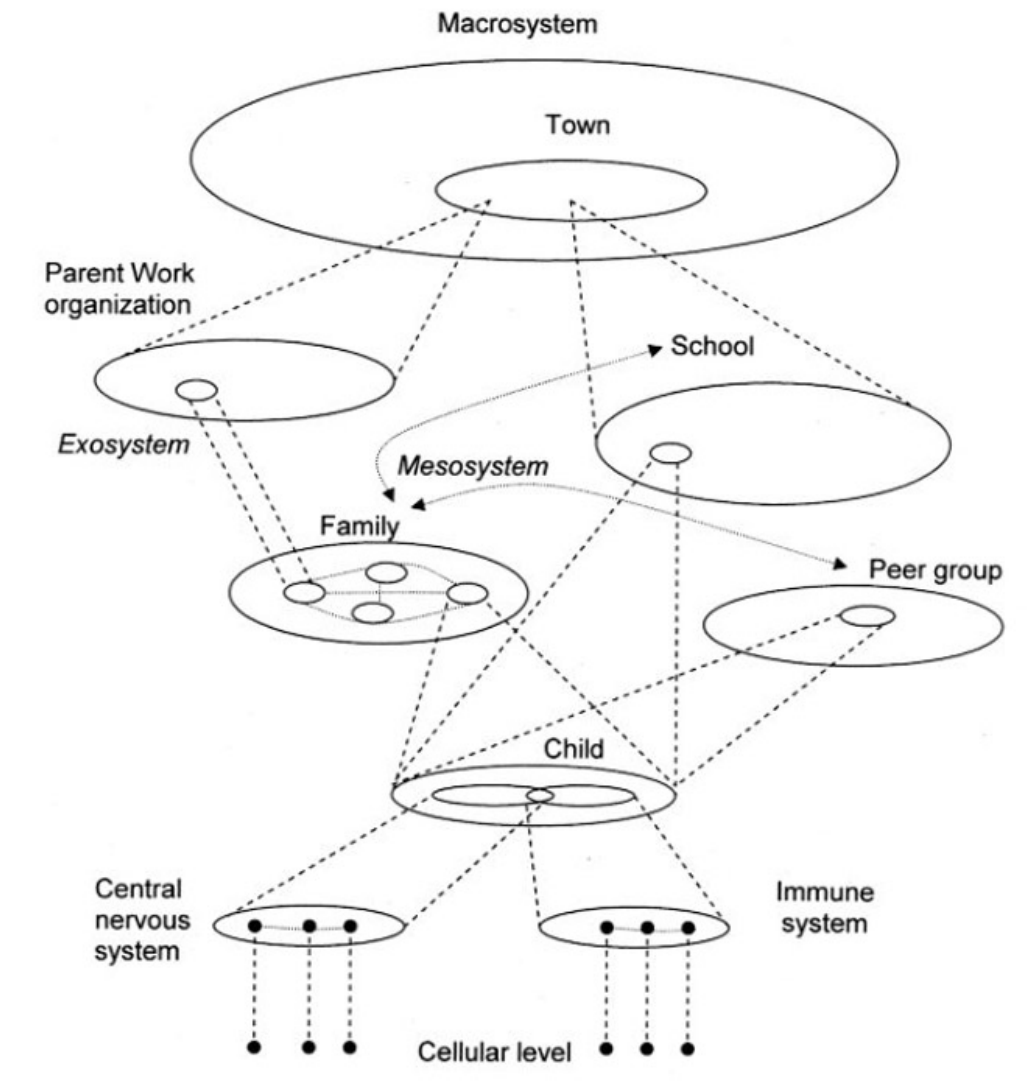
Fig. 2 . Multiple-level embedded systems that interact to influence a child’s life illustrating Bronfenbrenner’s (1979, 1986) concepts. The child as a living system is shown embedded in three microsystems, namely, family, peer group, and school. These microsystems are in turn embedded in a larger-scale systems, as shown for the school system, which is embedded in a town that is part of a larger macrosystem. Within the individual child, two inter-related internal systems are shown, i.e., the central nervous system and the immune system, each of which could be further differentiated at the cellular system level. Bronfenbrenner’s concept of the exosystem is illustrated by the parent work place, which influences the child indirectly through the parent. His concept of the mesosystem refers to interactions among the microsystems of the child, for example between parent and teacher or parent and